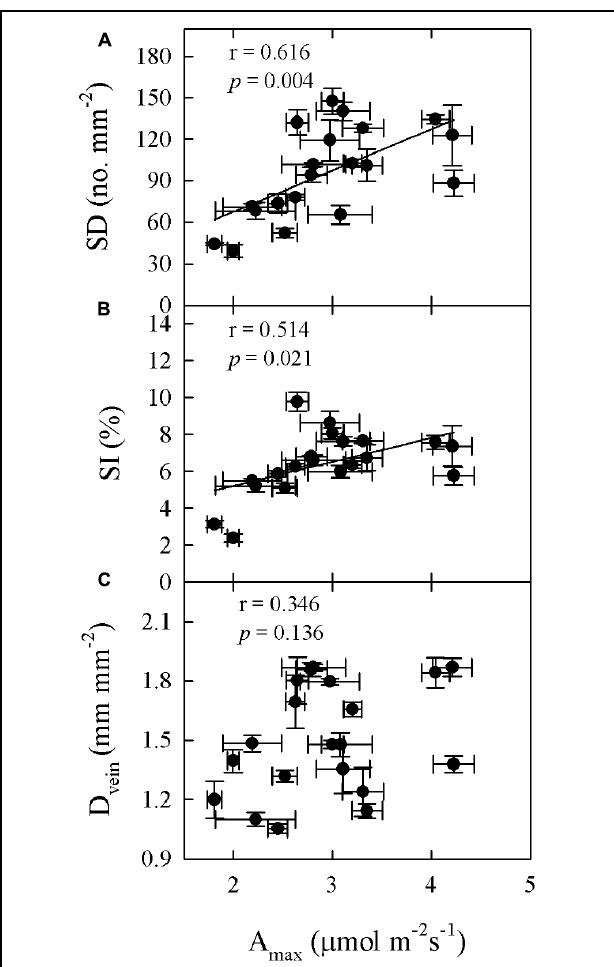
FIGURE 5 | Correlations between maximum photosynthetic rate (A max ) and SD (A), SI (B), and leaf vein density (D vein ; C) across 20 Cymbidium species.